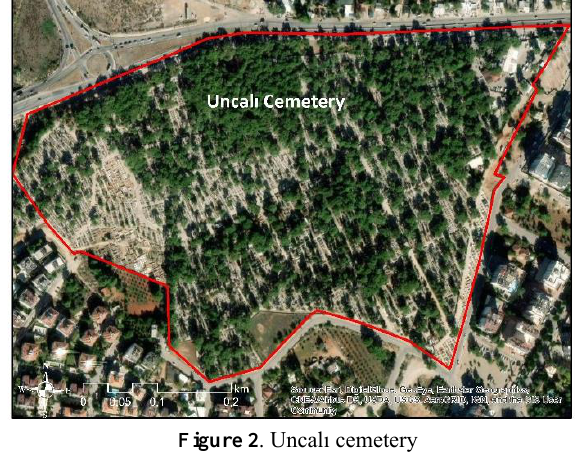
Figure 2 . Uncalı cemetery